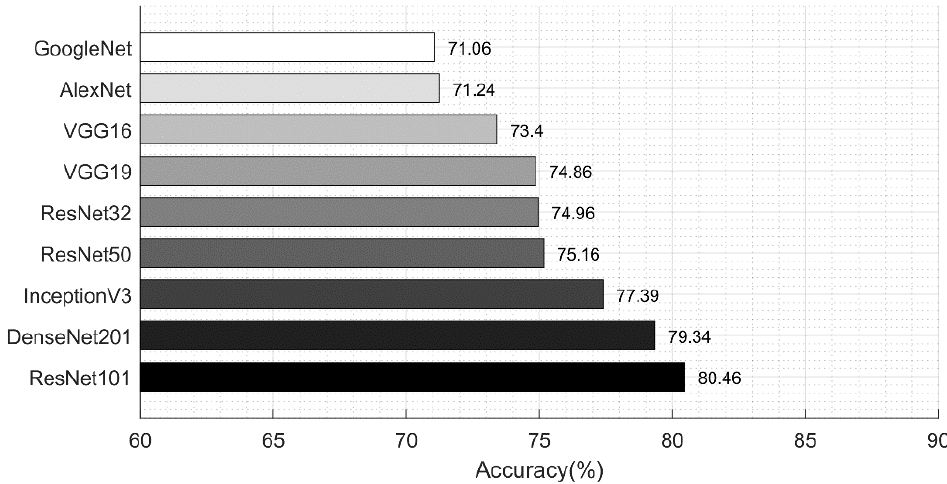
Figure 18. Comparison of neural network accuracy for skin lesion type classification.